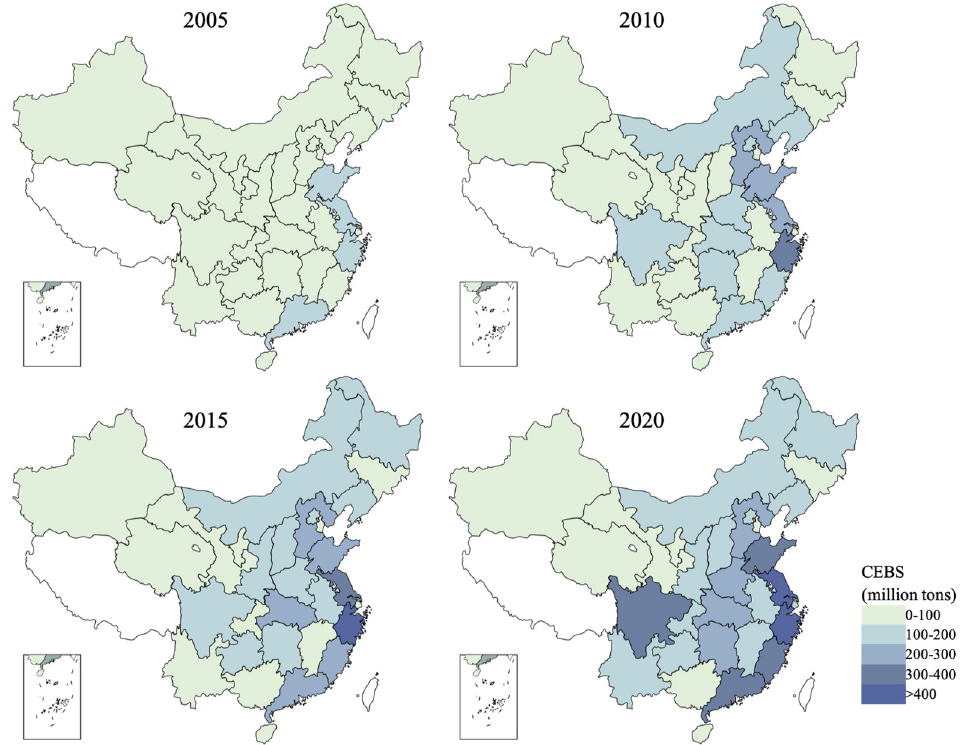
Figure 2. Distribution of the CEBS.